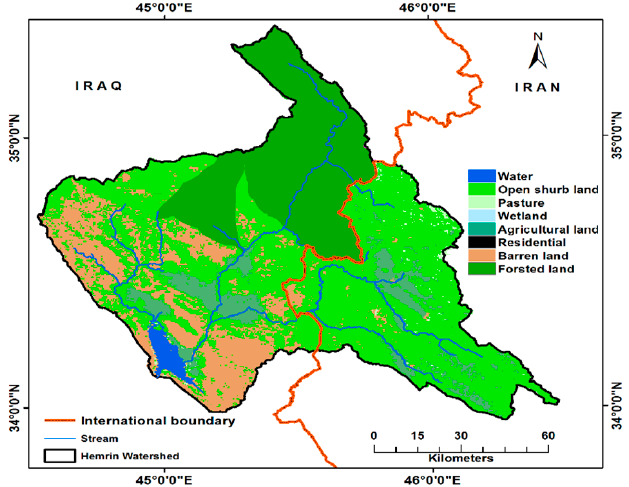
Figure 21. Senario-2 (M-2) of sediment mitigation in the Hemrin Watershed.